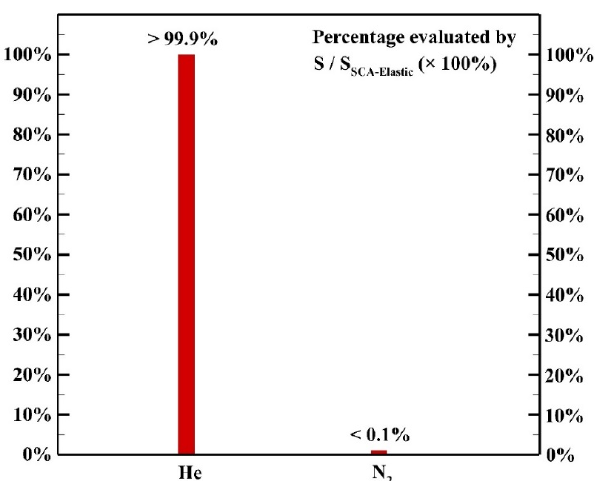
Figure 11. The contribution of each background gas to the heating source of elastic collision.